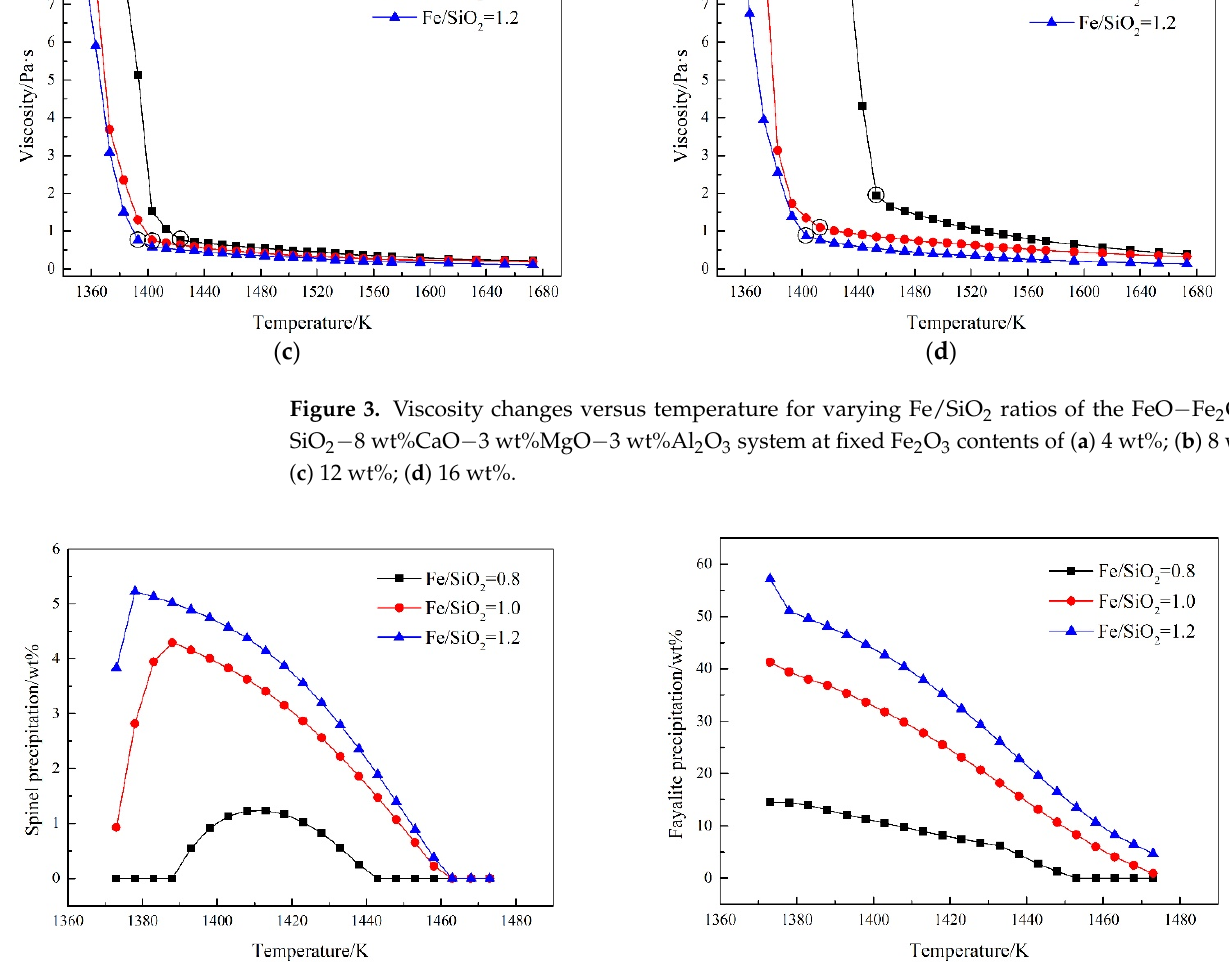
( c ) Figure 4. Effect of Fe/SiO 2 ratio on the cooling precipitation of crystalline phase at 1373–1473 K for 4 wt% Fe 2 O 3 content of ( a ) spinel; ( b ) fayalite; ( c ) clinopyroxene. The calculated cooling phase equilibrium of the slag at 1673–973 K (Fe/SiO 2 = 1.0, Fe 2 O 3 = 8 wt%) is given in Figure 5. According to Figure 5, with cooling, the spinel phase began to precipitate at 1575 K, accounting for 0.04%. The iron olivine phase began to pre- cipitate at 1465 K, accounting for about 0.41%, at which time the spinel precipitation had